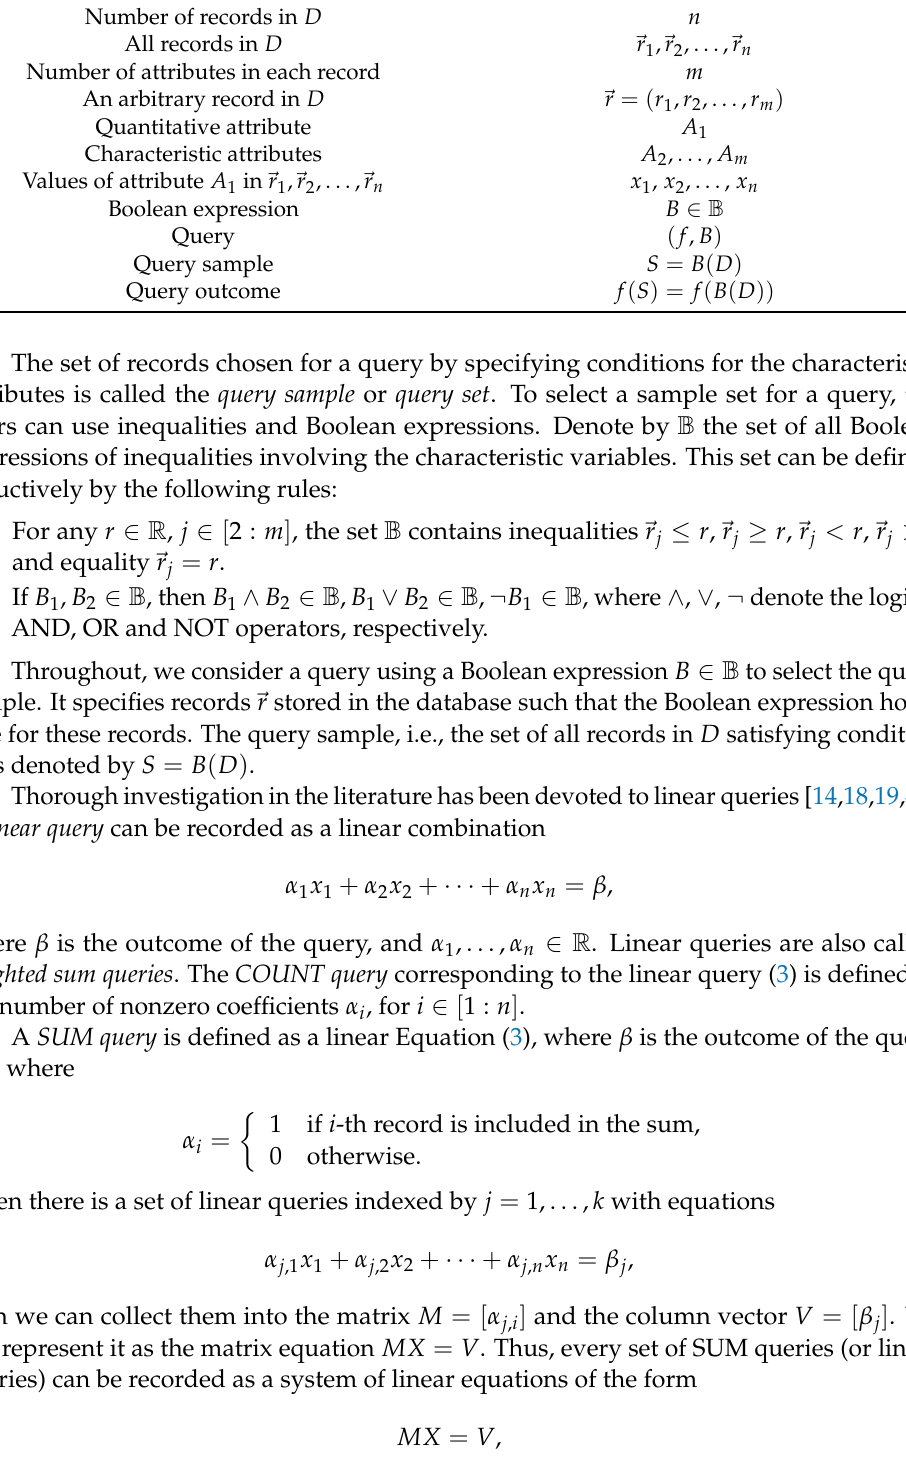
Table 1. Main terminology and notation used in the present paper. Term Notation Database with confidential data D Number of records in D n All records in D (cid:126) r 1 , (cid:126) r 2 , . . . , (cid:126) r n Number of attributes in each record m An arbitrary record in D (cid:126) r = ( r 1 , r 2 , . . . , r m ) Quantitative attribute A 1 Characteristic attributes A 2 , . . . , A m Values of attribute A 1 in (cid:126) r 1 , (cid:126) r 2 , . . . , (cid:126) r n x 1 , x 2 , . . . , x n Boolean expression B ∈